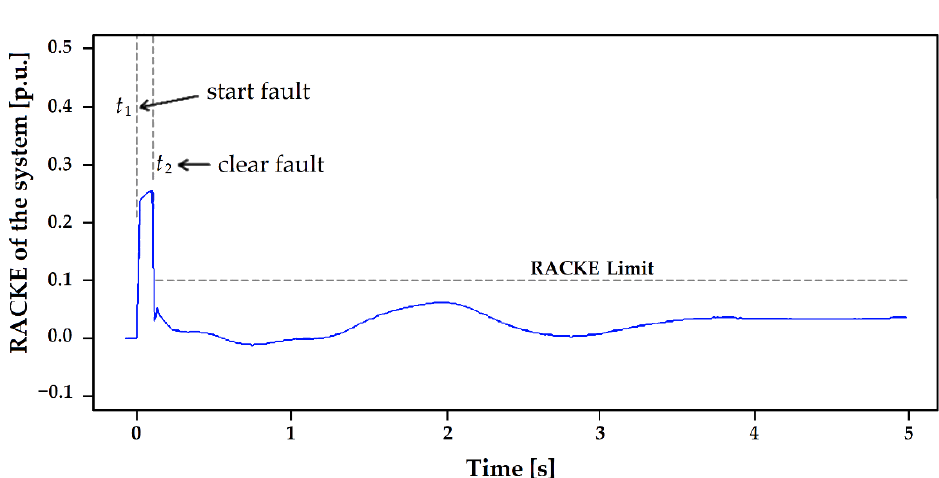
Figure 15. RACKE_SIS vs. time and the critical case of stability.